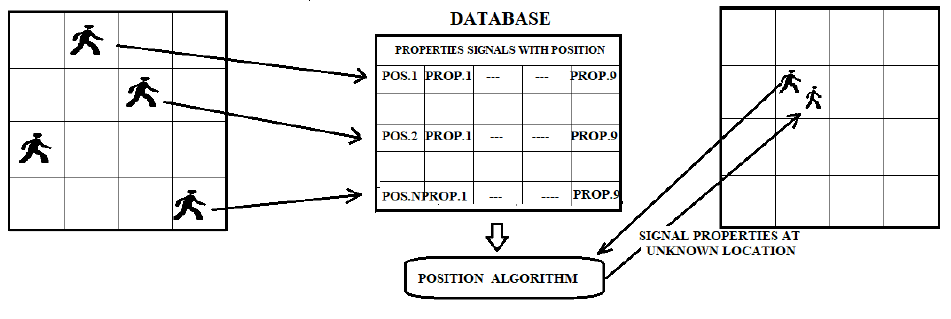
Figure 11. Diagram of the fingerprinting process flow.